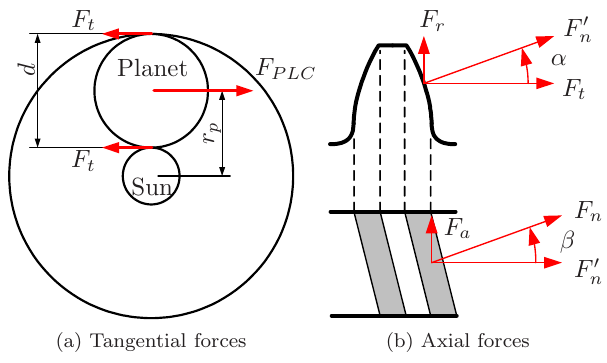
Figure 5: Calculation of